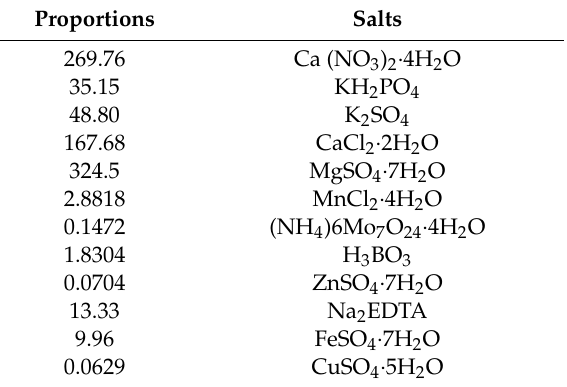
Table 1. Chemical composition and proportions of Hoagland’s solution used in the hydroponic. Proportions